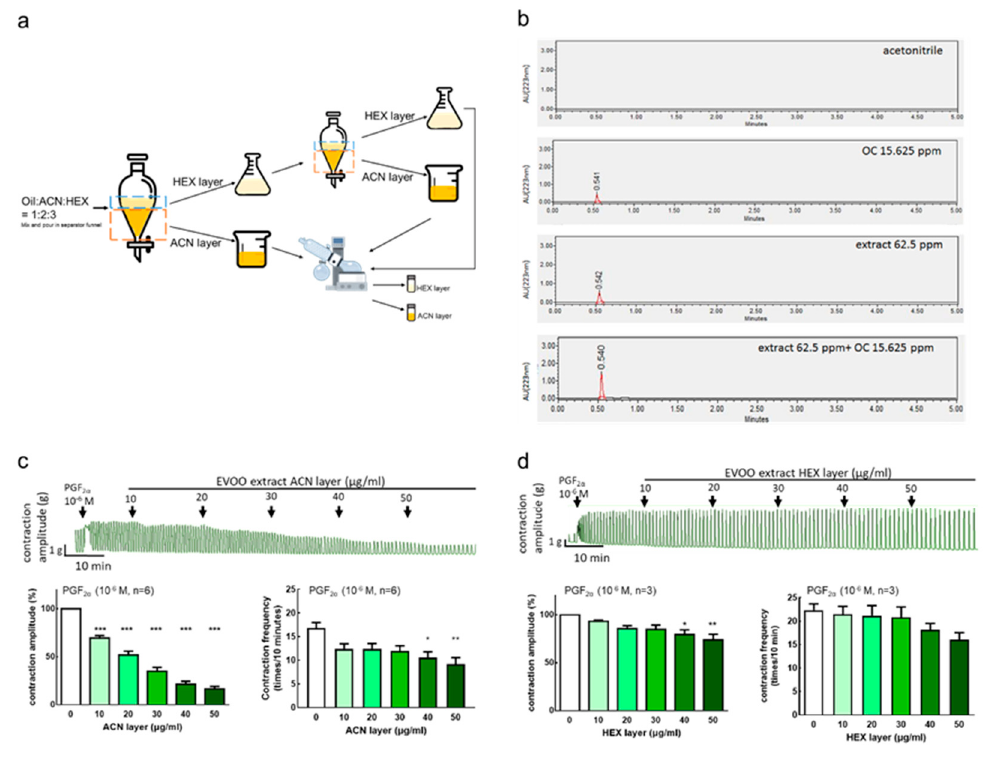
Figure 4. Effects of extra virgin olive oil (EVOO) extracts on prostaglandin F2 α -induced uterine contraction in rats. The representative recordings, mean peak amplitude, and mean peak frequency of prostaglandin F2 α (PGF2 α )-induced contractions are presented. ( a ) The EVOO extraction process. ( b ) ultra-performance liquid chromatography (UPLC) of acetonitrile, oleocanthal at 15.625 ppm, and extra virgin olive oil ACN layer extracts at 62.5 ppm, as well as the mixture with oleocanthal at 15.625 ppm and extra virgin olive oil Acetonitrile (ACN) layer extracts at 62.5 ppm. ( c ) EVOO ACN layer extracts (10–50 μ g/mL) and ( d ) EVOO Hexane (HEX) layer extracts (10–50 μ g/mL). Data are presented as the mean ± standard error of mean (SEM) ( n = 3–6). * p < 0.05, ** p < 0.01, *** p < 0.001 versus 0 μ g/mL. OC: Oleocanthal